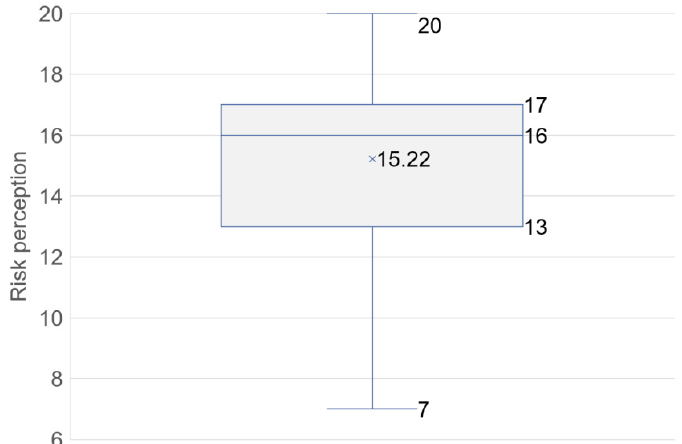
Figure 5. Measurement of risk perception.